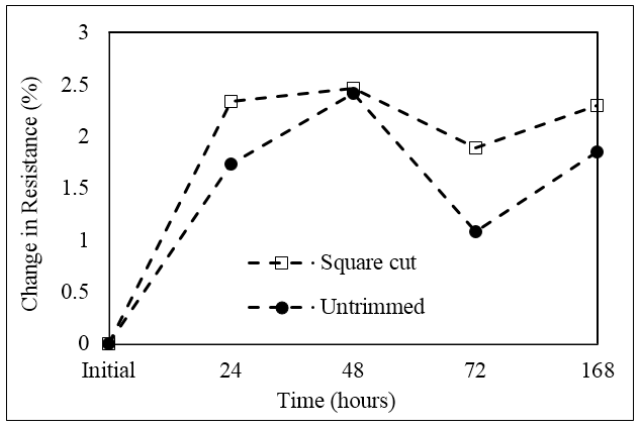
Figure 10. Average change in resistance for untrimmed and square cut trimmed shunt resistor samples during storage at 200 °C for 168 h.